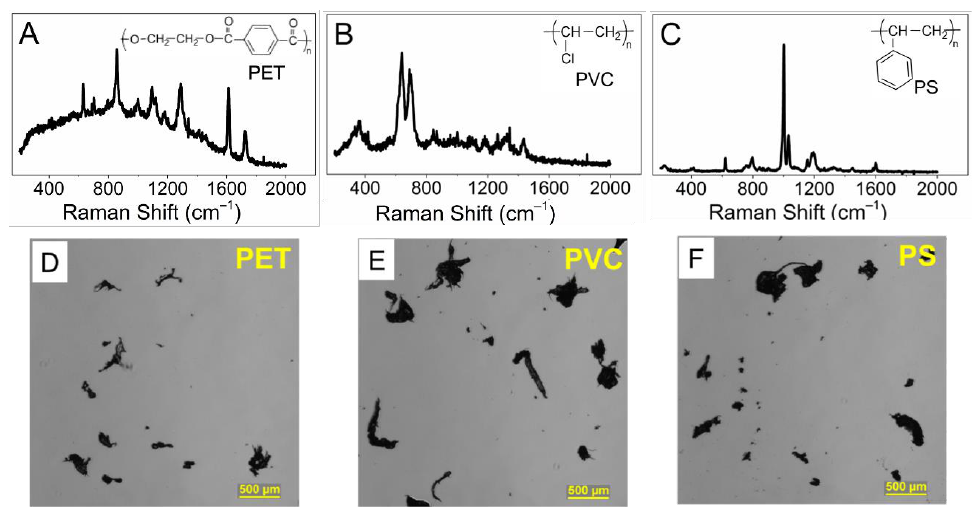
Figure 1. Raman spectra and molecular structures of the plastic items in this work: ( A ) a water bottle (PET), ( B ) a plastic sheet (PVC) and ( C ) a plastic spoon (PS). Optical microscope images of the ( D ) PET, ( E ) PVC and ( F ) PS microplastics prepared by grating the plastic items. 3.2. Comparison of Mg 2+ , Mn 2+ and Zn 2+ for ssDNA Adsorption